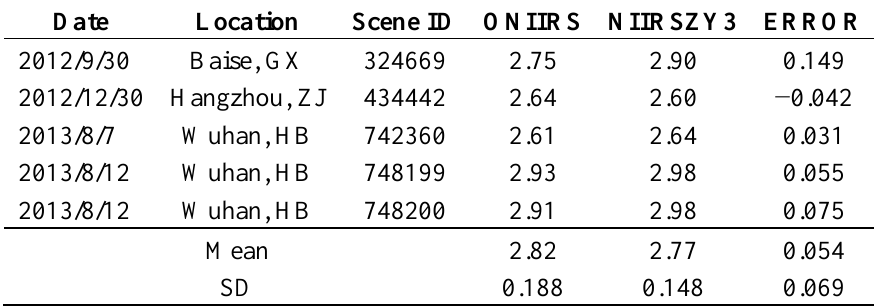
Table 7. Result of the validation.